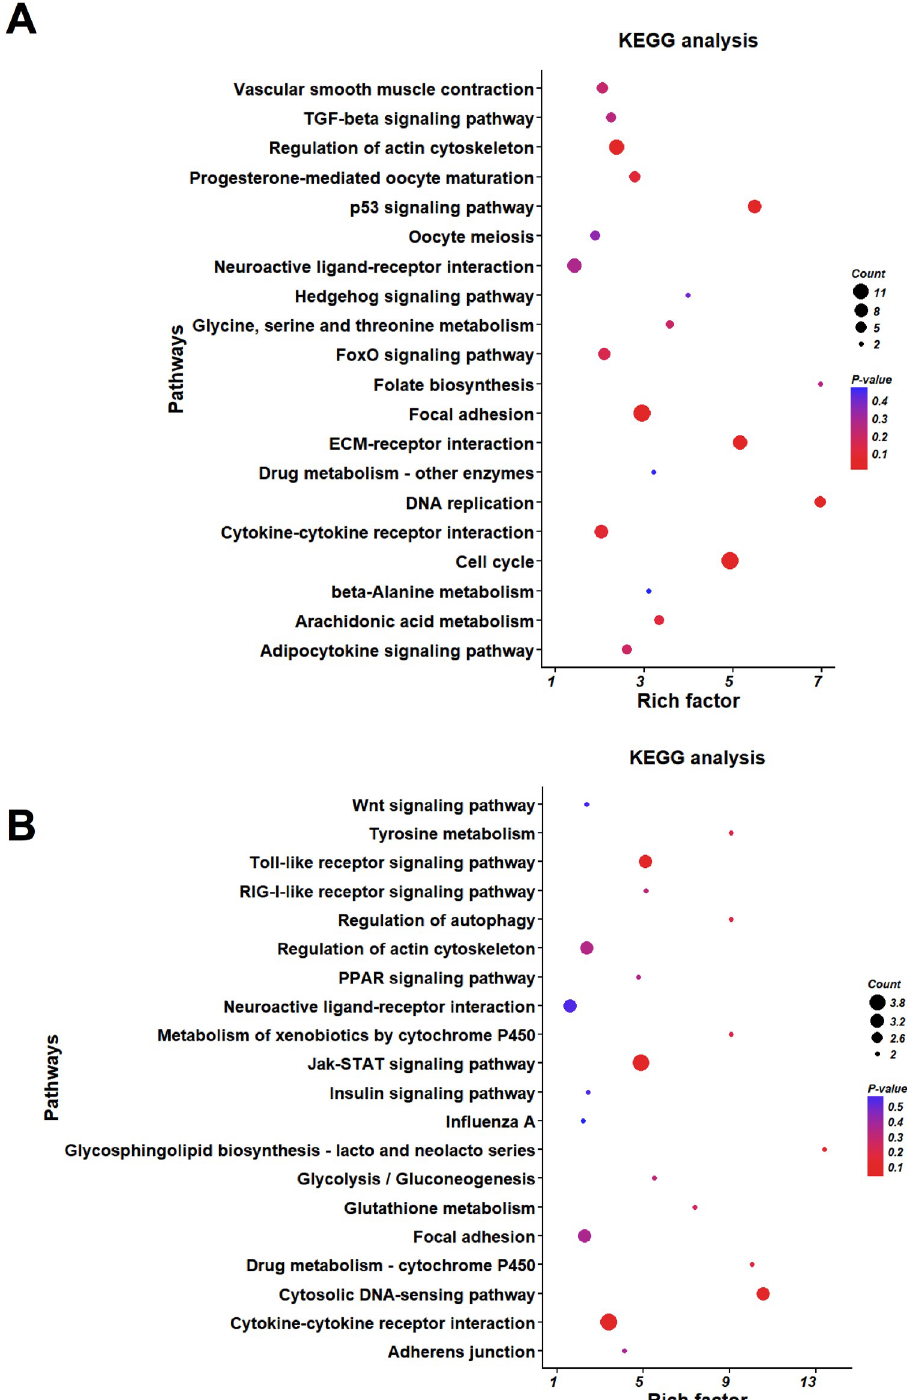
Fig 5. KEGG analysis of the DEGs induced by FOXL2 silencing in the chicken granulosa cells. (A) KEGG enrichment analysis of DEGs in the comp. poGC. (B) KEGG enrichment analysis of DEGs in the comp. phGC. The 20 pathways in which the top DEGs were found are summarized. The Y-axis and X-axis indicate functional pathways and the enrich factor for the DEGs in the same pathway, respectively.